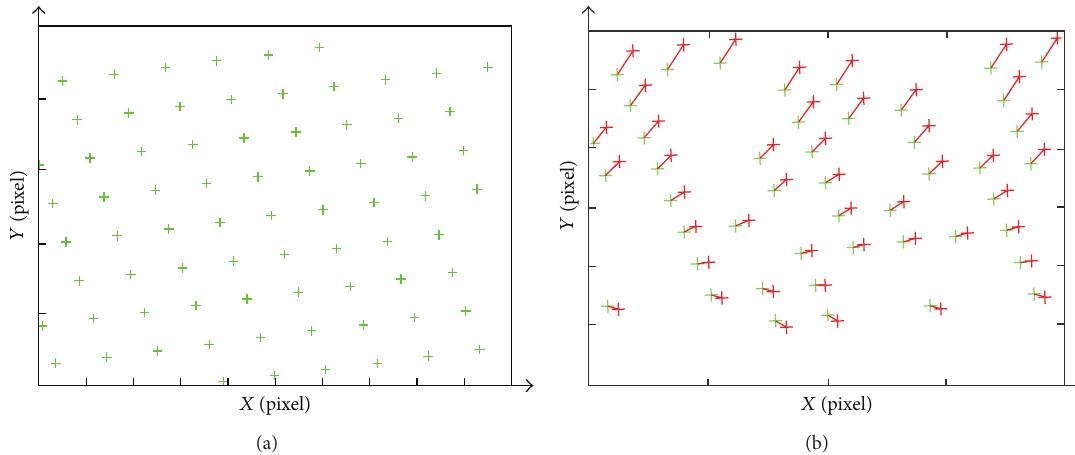
Figure 2: (a) Diagram of the distribution of GCPs; (b) the error’s distribution of image points corresponding to GCPs.